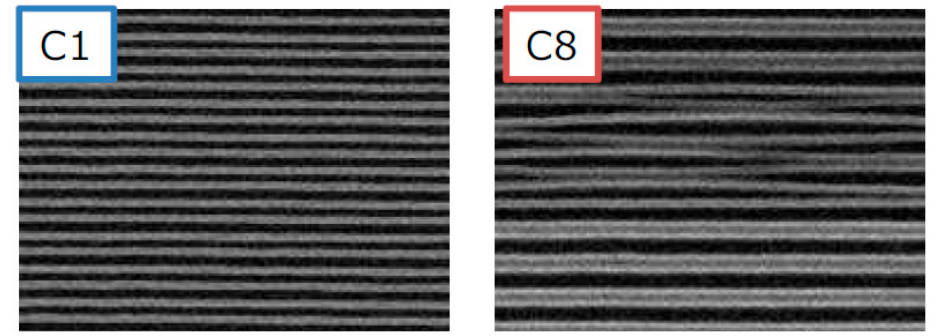
Figure 40. Top-view SEM image of samples treated with C1 and C8 after drying [243].